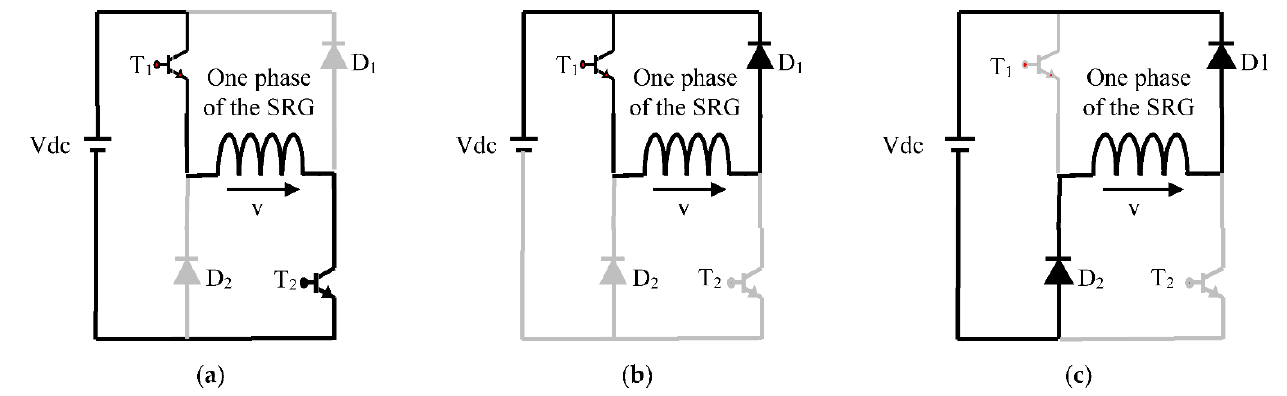
Figure 9. Possible states of the supply voltage for a phase of the SRG: ( a ) unaligned position voltage positive + Vcc: two switches are closed; ( b ) Voltage zero “0”: one switch is open and the other is closed; ( c ) Voltage negative − Vcc: two switches are closed.